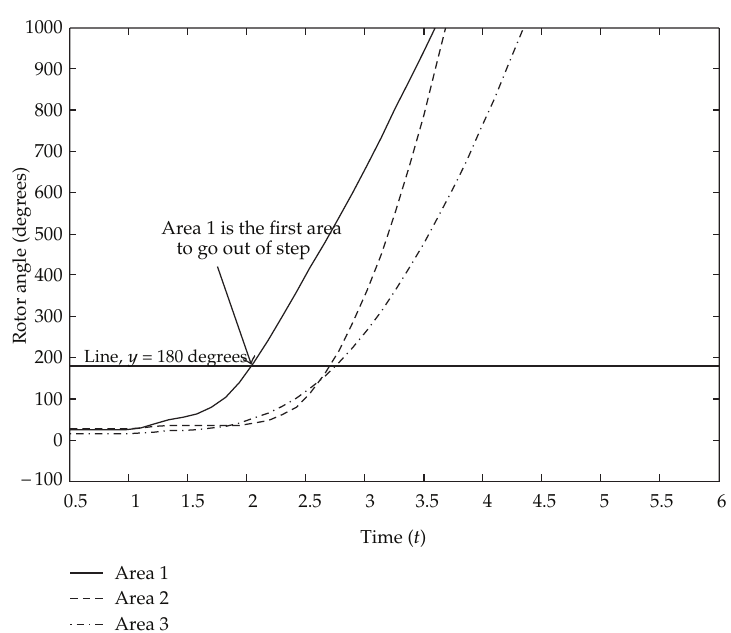
Figure 3: The Area 1 COI-referred rotor angle goes out of step the